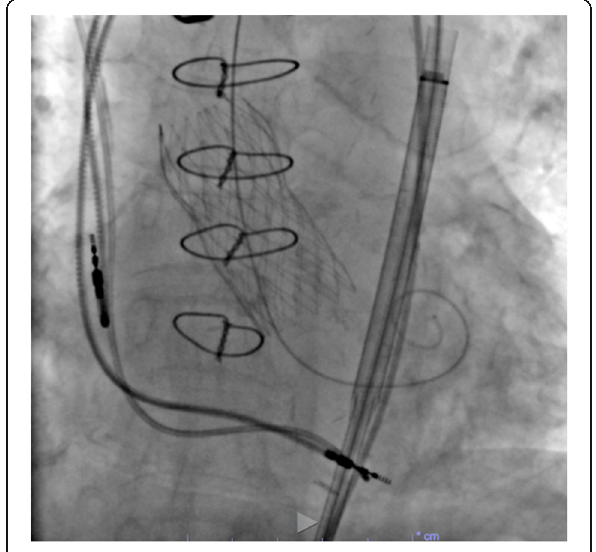
Fig. 3 Fluoroscopy during transcatheter aortic valve implantation with a self-expanding device (26-mm Evolut R